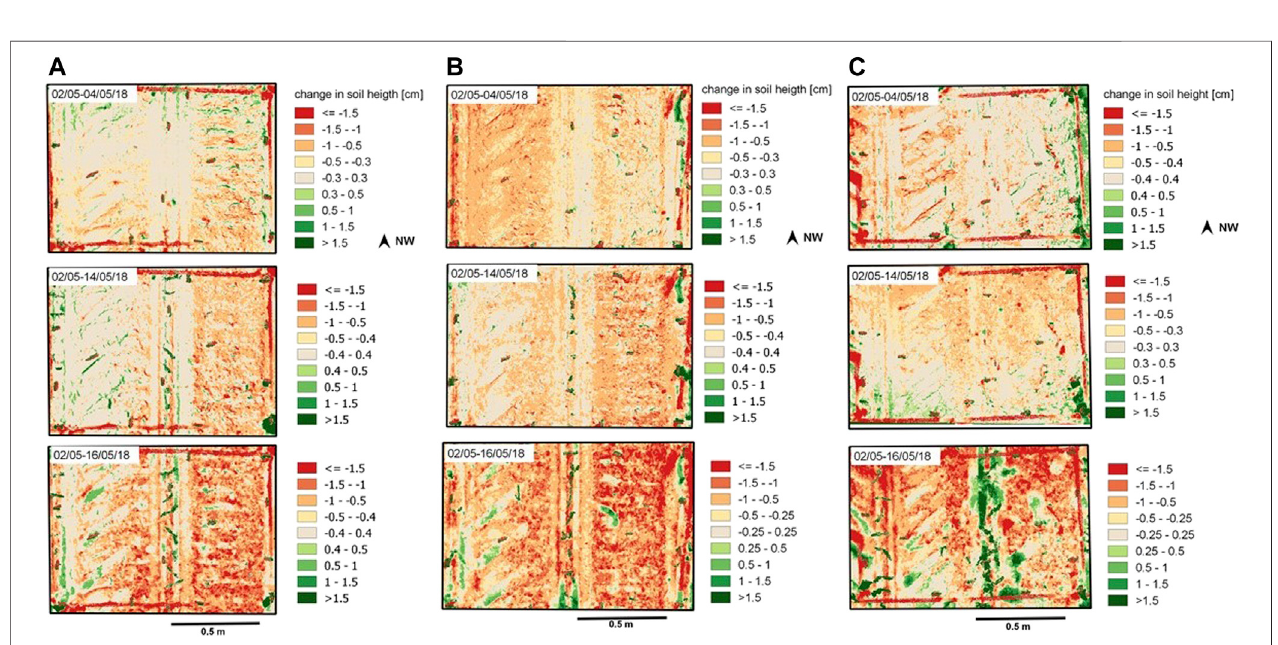
FIGURE 4 | Maps of changes in soil surface elevation (micro-topography) calculated from the SfM-derived DEM ’ s of two dates (i.e., DoD) at the plots of (A) the upper-, (B) the middle-, and (C) the footslope position during the period between May 2 and May 16; see Supplementary Appendix SA5 for DEMs.